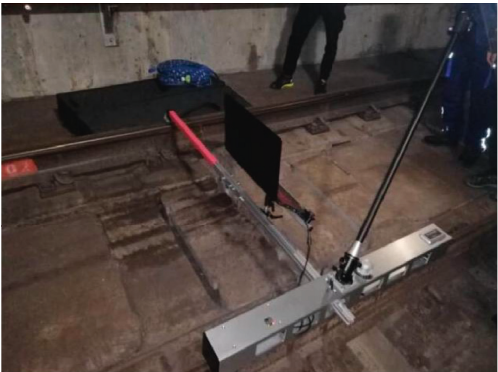
Figure 3: Measurement of rail with wave corrugation.